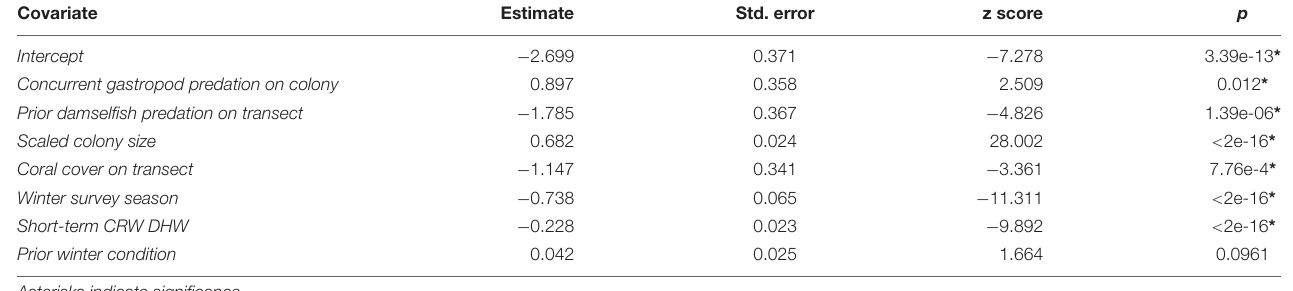
TABLE 3 | Summary of final full model fit to random training partition (75% of available data). Covariate Estimate